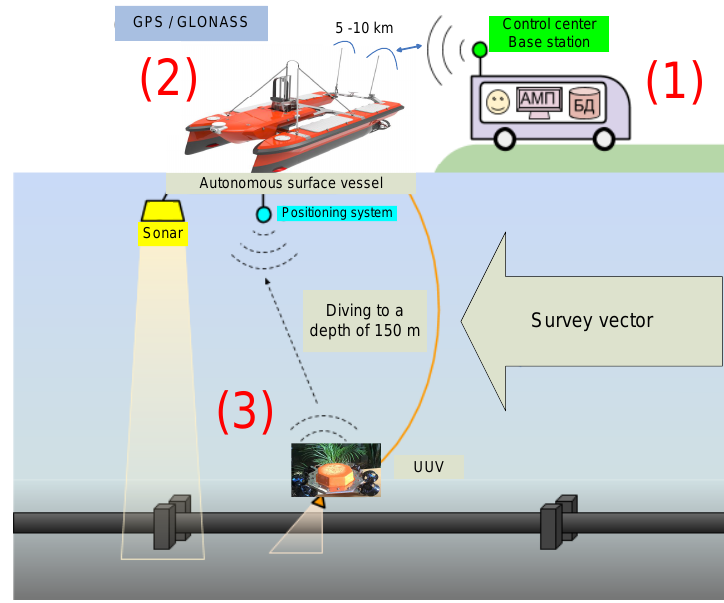
Figure 1. The pipeline monitoring